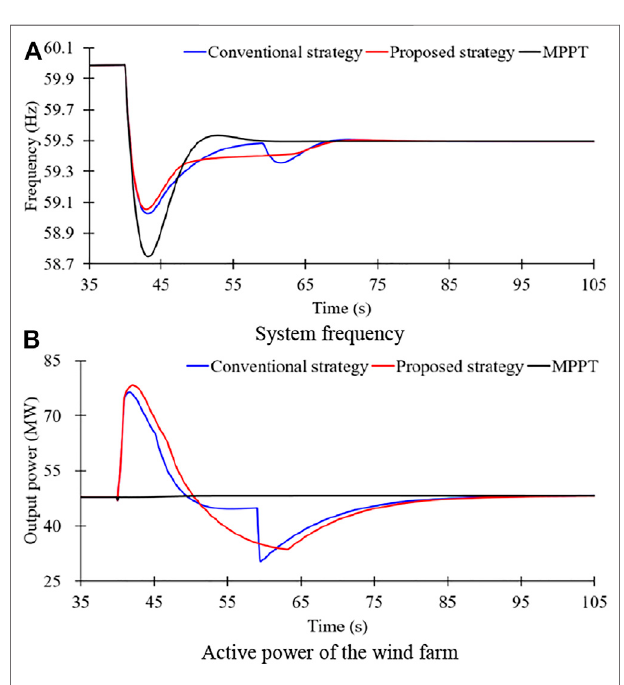
FIGURE 12 | Results for case 3.